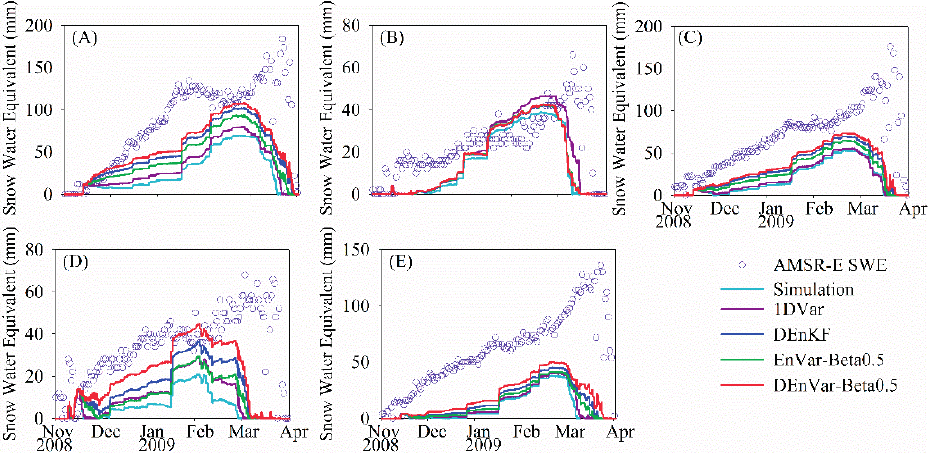
Figure 5. Comparison of the SWE time series from AMSR-E retrieved SWE and the assimilated results from different DA experiments at the ( A ) Aletai, ( B ) Buerjin, ( C ) Fuyun, ( D ) Jimunai, and ( E ) Qinghe sites.